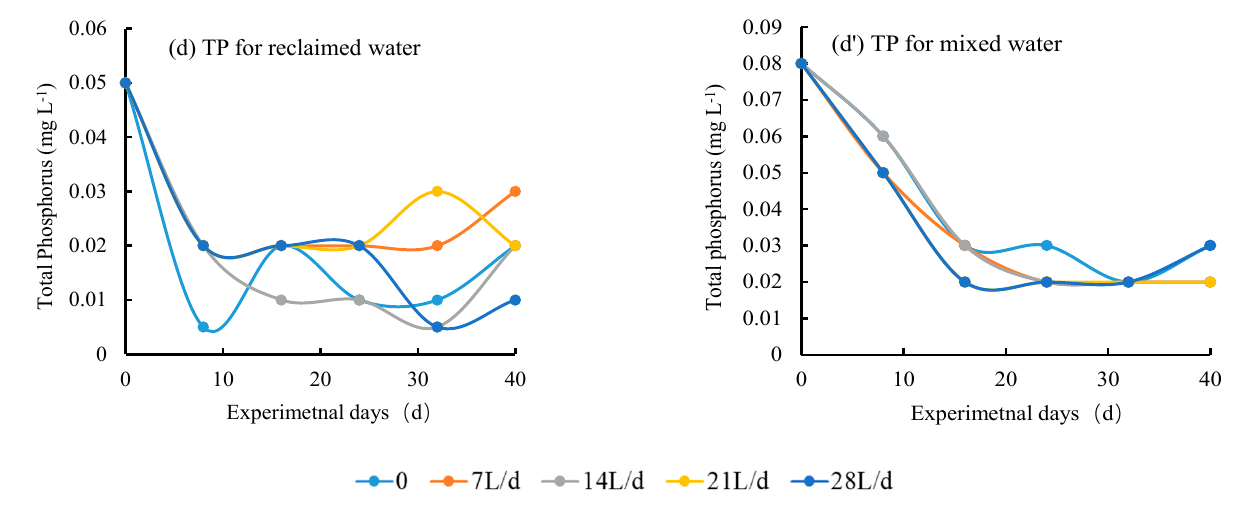
Figure 2. Temporal variations in COD Mn , NH3–N, TN and TP concentrations during the experimental period (40 days). For different exchange flow rates (( a – d ) for the reclaimed water and ( a’ – d’ ) for mixed water).